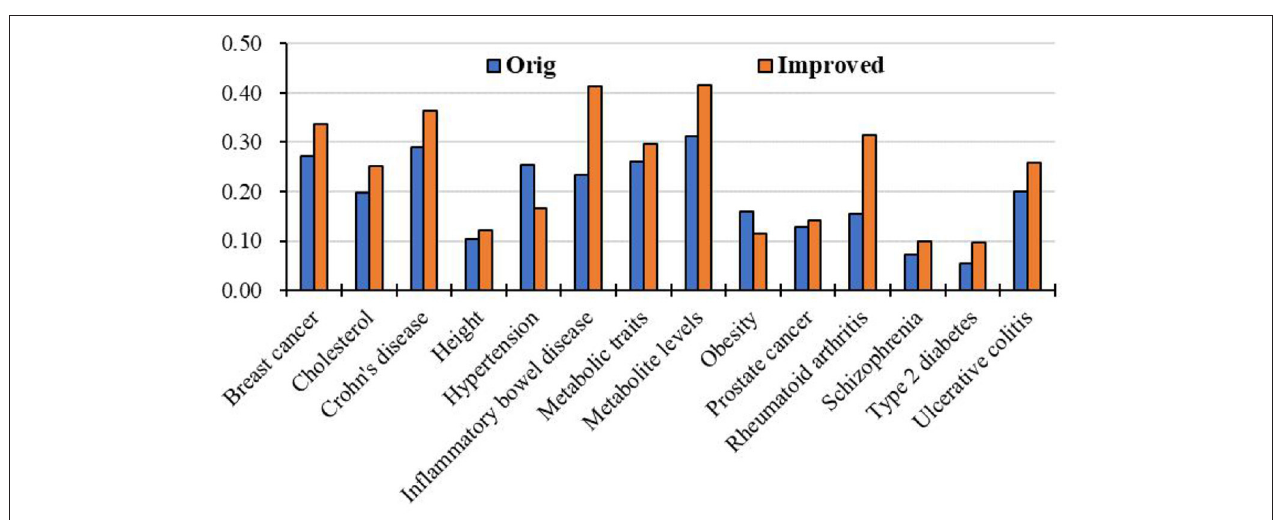
FIGURE 9 | Top 5% Recall for different diseases in the PPI network with KEGG